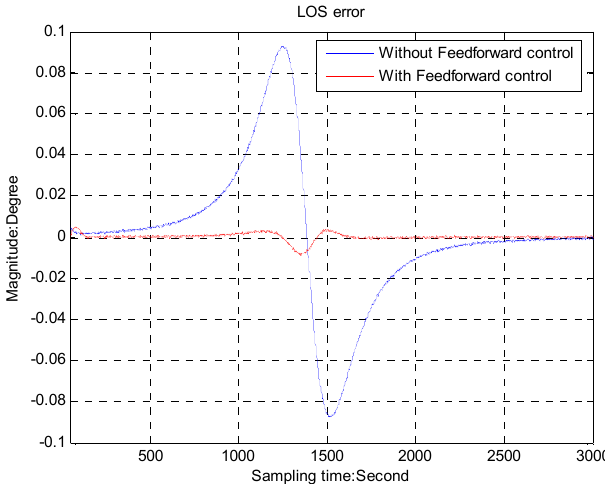
Figure 8. LOS error for the simulative target.